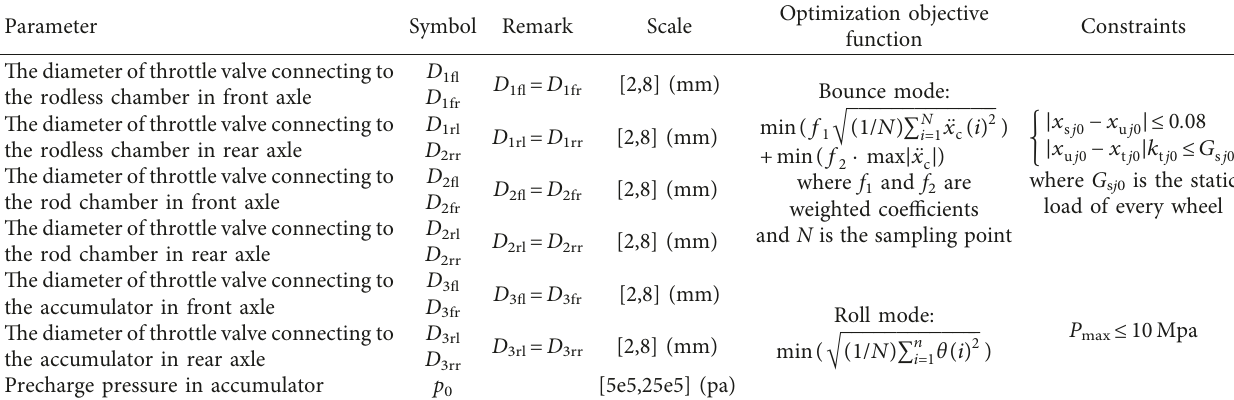
Table 3: Parameter optimization for HIS-based semiactive control suspension system.